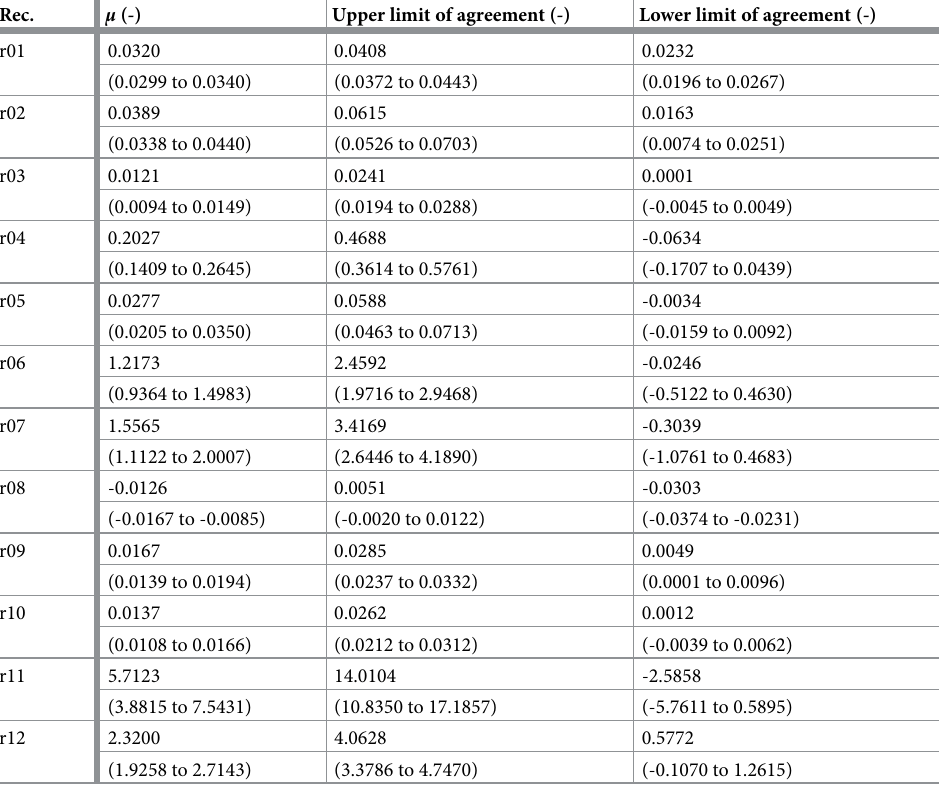
Table 6. Mean values μ and values of limits of agreement determined for ST segment analysis (the 95% confidence interval is reported in parenthesis).